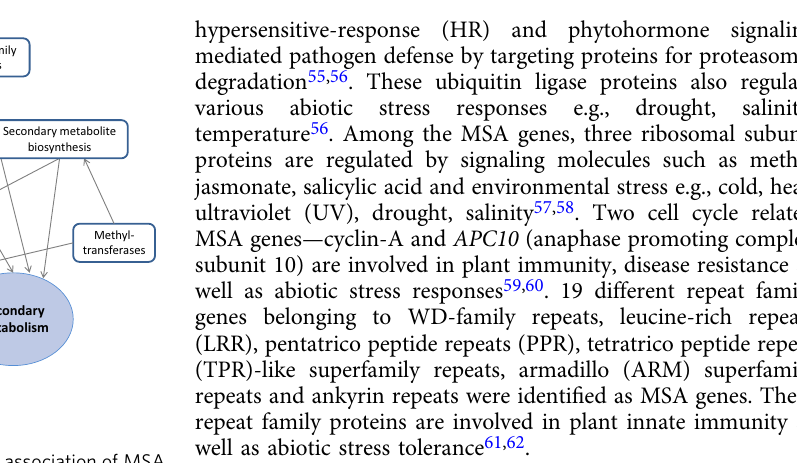
Fig. 2 Functional categories of MSA genes. Functional association of MSA genes with medicinal properties of C. longa